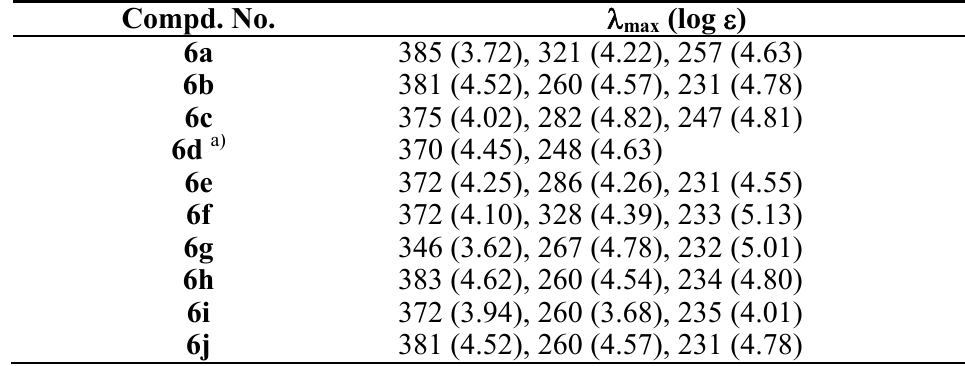
Table 1. UV Spectra of 3-arylhydrazono-4-phenyl-1 H -[1,2,4]triazepino[2,3- a ]quinazolin- 2,7-diones 6a–j in dioxane.